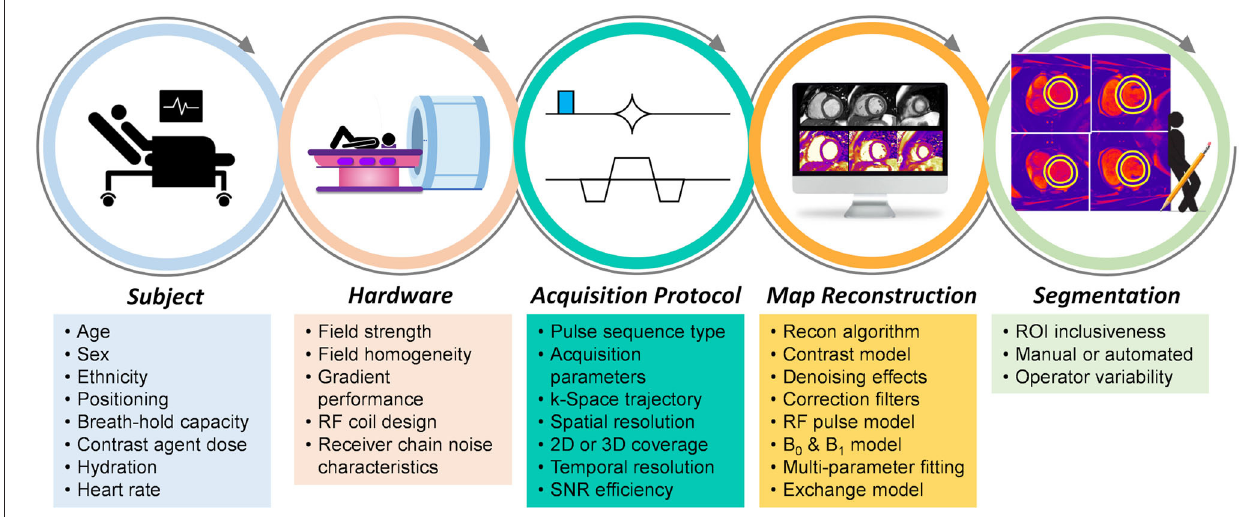
FIGURE 1 | Sources of bias and variability in the myocardial mapping workflow. Various factors at each step contribute to the bias and variability of the obtained relaxation time when using myocardial parametric mapping. Not all factors contribute significantly to all mapping techniques, while some factors cancel one another, and some are included on purpose to increase